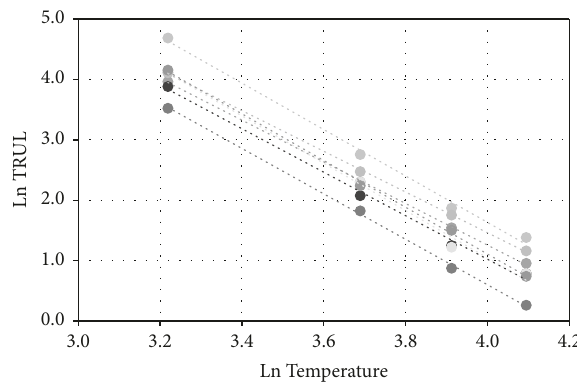
Figure 3: Correlation between TRUL and temperature for 𝐾 232 (TRUL = 𝑎𝑇 𝑏 ) . Seven samples denoted in seven shades { adopted from Mancebo-Campos et al. (2008) [23] }